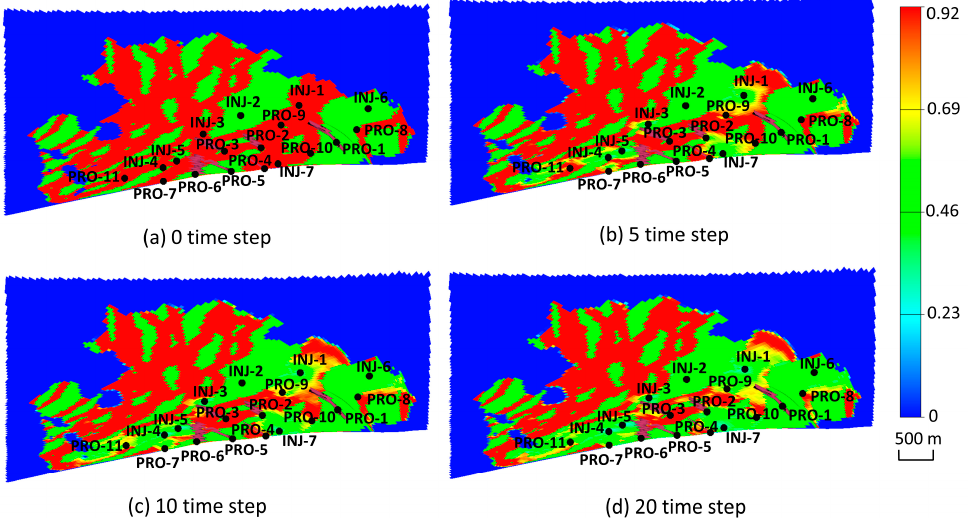
Figure 10. The oil saturation distribution at different time steps of Olympus model.